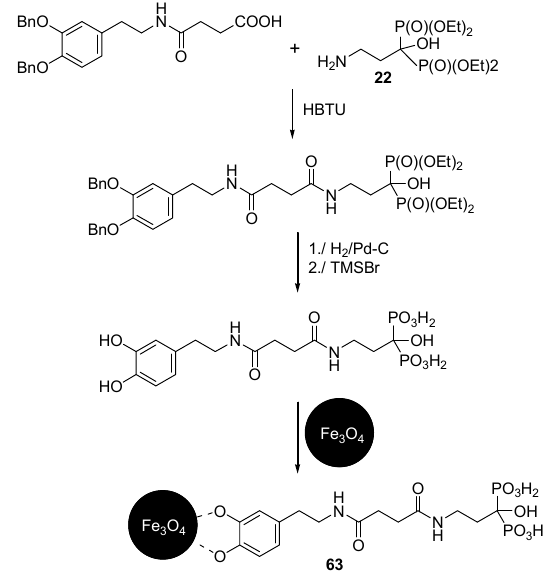
Scheme 32. Bisphosphonylated methacrylamide monomers.